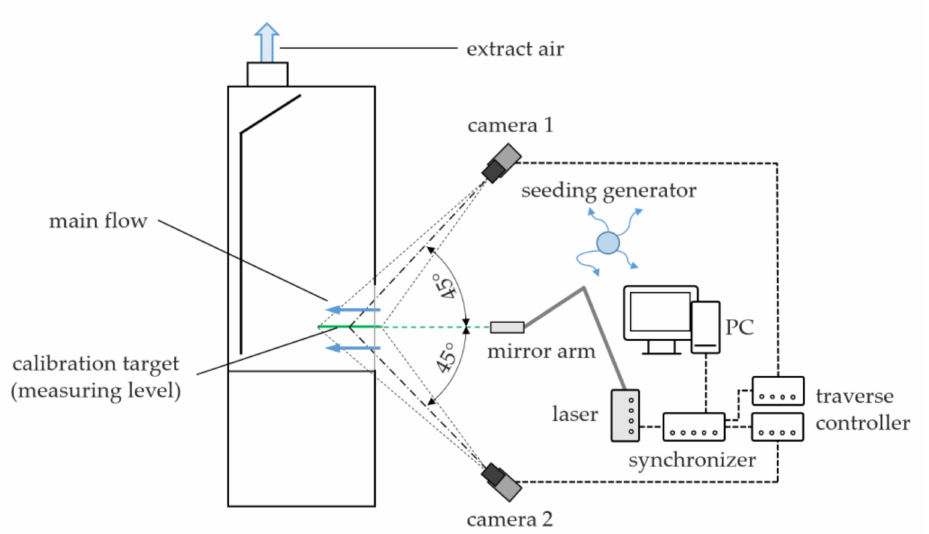
Figure 16. Experimental setup for Stereo PIV measurements on the side post and the subsequent side wall—schematic